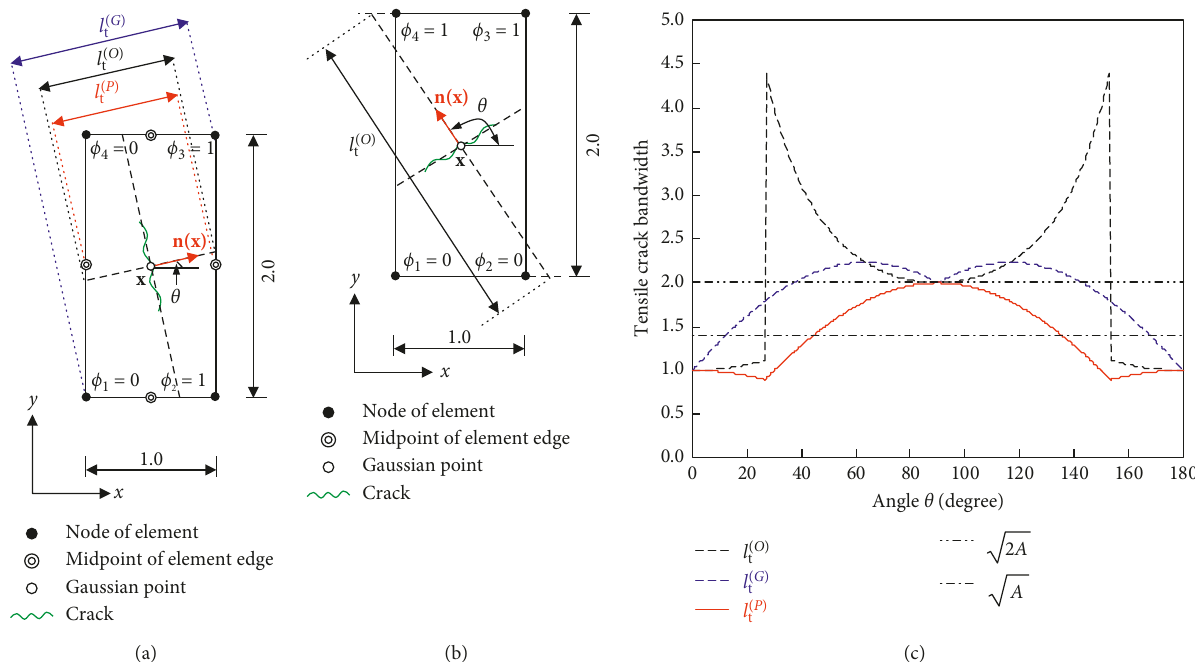
Figure 4: Comparison of estimations of crack bandwidth for a rectangular quadrilateral element: (a) geometrical meanings of crack bandwidths estimated by the present model, Oliver [56], and Govindjee et al. [58]; (b) large crack bandwidth estimated by the first method of Oliver [56]; (c) relations of tensile crack bandwidth and angle θ